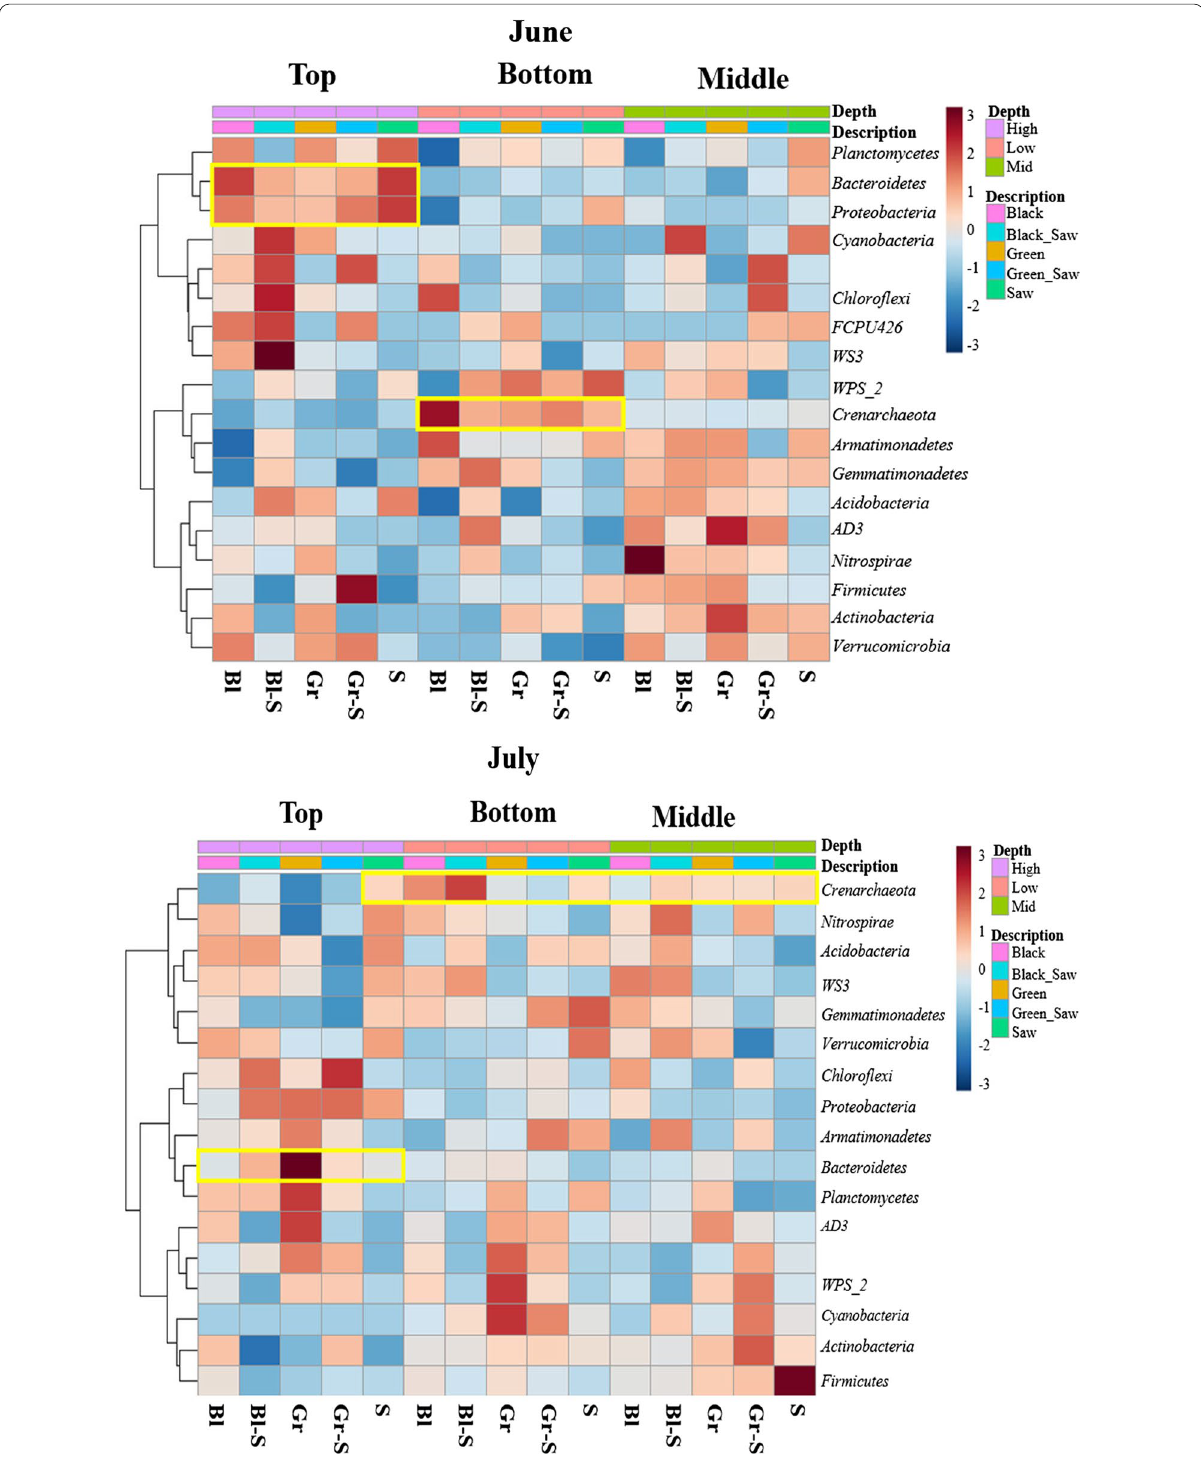
Fig. 4 Heat map of microbial communities of soil based on phylum level. S sawdust, Gr green weed mat, Gr-S sawdust topped with green weed mat, Bl black weed mat, and Bl-S sawdust topped with black weed